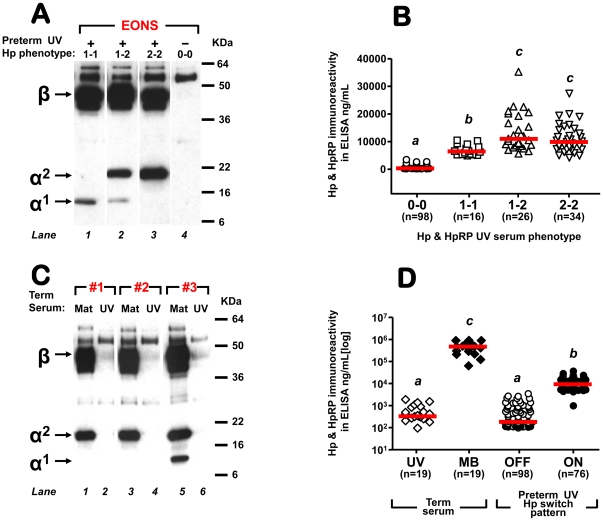
Cord blood haptoglobin (Hp) and haptoglobin-related protein (HpRp) immuno-reactivity revealed by Western blot (A&C) and ELISA (B&D) using antibodies reactive with both Hp and HpRP.(A) Western blot of umbilical vein (UV) serum from 4 preterm newborns of similar gestational age at birth. The newborns in Lanes 1-3 were categorized as having early-onset sepsis (EONS) based on clinical manifestations and hematological indices and all received i.v. antibiotics. The newborn in Lane 4 had a negative sepsis work-up. Blood cultures remained negative for all 4 newborns. The presence of a conspicuous immunoreactive band corresponding to the β-chain (∼42 kDa) in Lanes 1-3 is consistent with our defined switched-on Hp pattern. The absence of this band indicates for a switched-off pattern in Lane 4. The band ∼9 kDa (Lanes 1&2) corresponds to the α1-chain whereas the band at ∼20 kDa (Lanes 2-3) corresponds to the α2-chain. Thus, the cord blood Hp patterns and phenotypes depicted in this gel are: switched-on pattern and Hp1-1 (Lane 1), switched-on pattern and Hp1-2 (Lane 2), switched-on pattern and Hp2-2 (Lane 3) and switched-off pattern and Hp0-0 (Lane 4). In our cohort, among preterm newborns with switched-on Hp pattern (present β-chain, n = 81), the distribution of Hp phenotypes was as follows: 6.0% Hp0-0 (5/81, no α-chain detected), 19.3% (16/81) Hp1-1, 32.5% (26/81) Hp1-2, and 42.1% (34/81) Hp2-2. The higher band intensity of the α2-chain compared to that of the α1-chain suggest that phenotype impacts on total Hp immunoreactivity. (B) Impact of Hp phenotypes on Hp&HpRP immunoreactivity as measured by ELISA. The red line indicates the group's median. Groups assigned different letters are statistically different at a P<0.05 (Kruskal-Wallis ANOVA). (C) Western blot of 3 representative maternal (Mat) and UV serum retrieved from women with normal deliveries at term. Note the switched-off pattern of the cord blood in contrast to the switched-on pattern of the adult blood. The Hp phenotypes of the mothers are Hp2-2 (Cases #1 and #2) and Hp1-2 in Case #3. (D) Quantitative comparison of Hp&HpRP immunoreactivity measured by ELISA in 19 UV and maternal blood (MB) serum from 19 normal deliveries at term relative to Hp&HpRP immunoreactivity measured in preterm UV with either switched-off or switched-on Hp pattern. The red line indicates the group's median. Groups assigned different letters are statistically different at a P<0.05 (Kruskal-Wallis ANOVA).